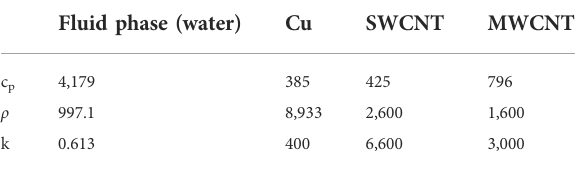
TABLE 1 Thermal properties of the base fl uid (water) and